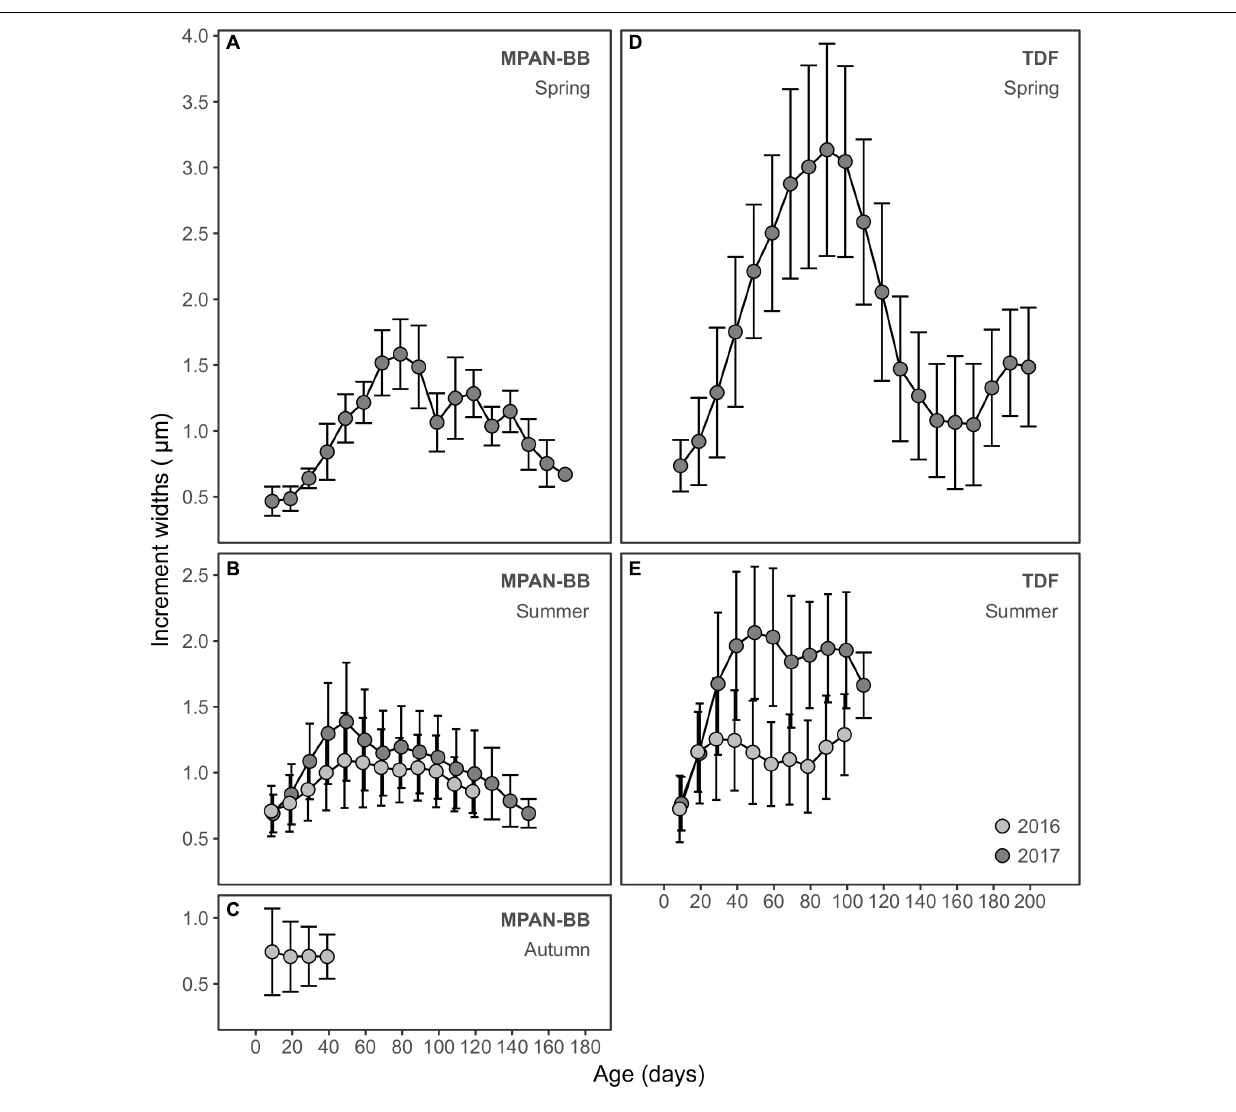
Frontiers in Marine Science |